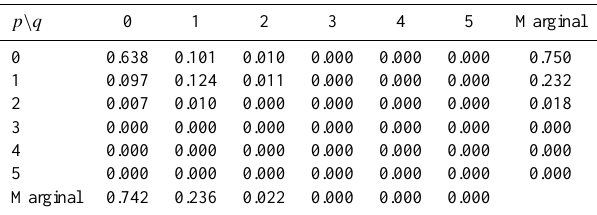
Table 6. Posterior model probabilities for Nile minima time series for the autoregressive parameter p and moving average parameter q .